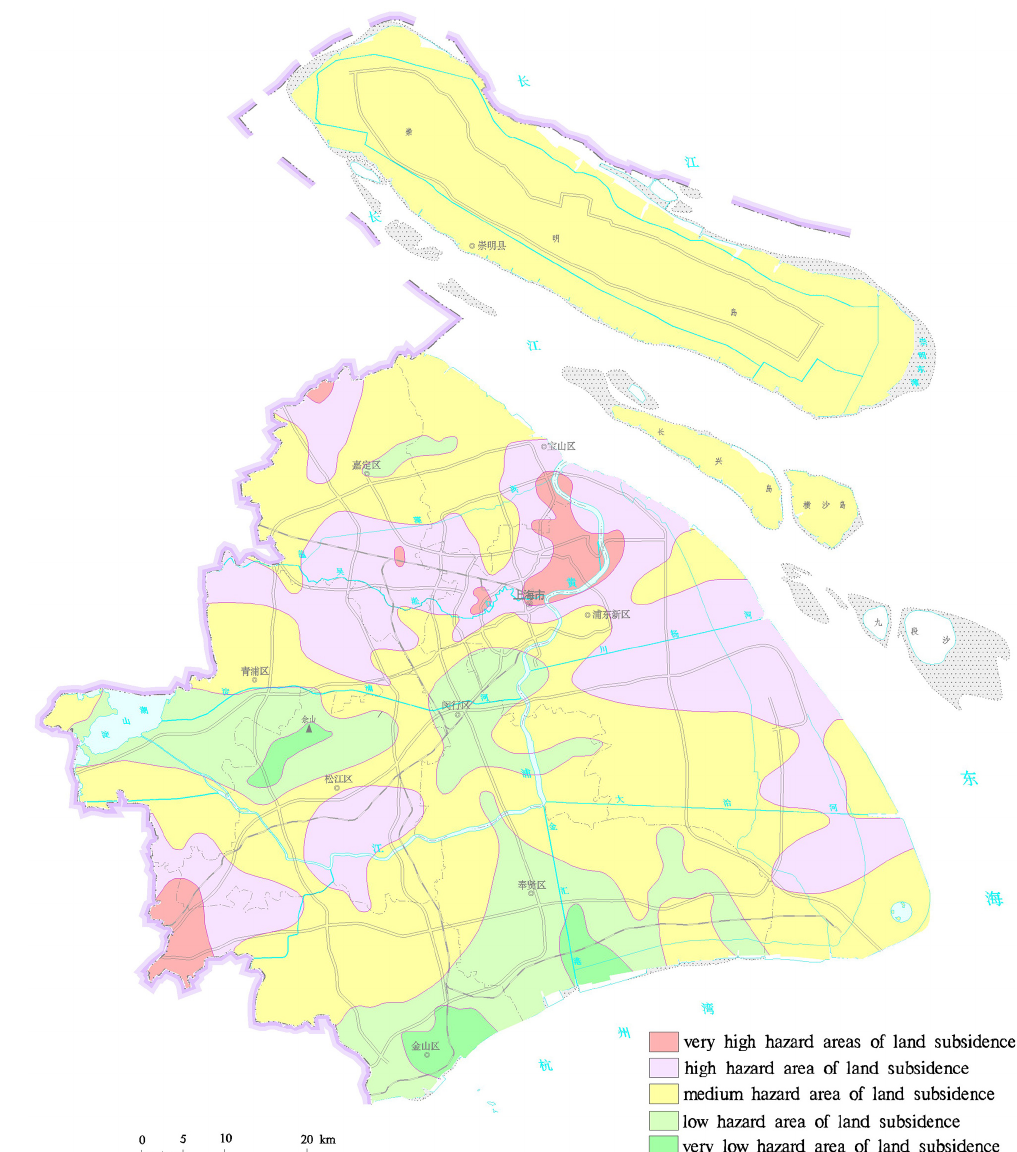
Figure 1. Hazard evaluation of land subsidence in